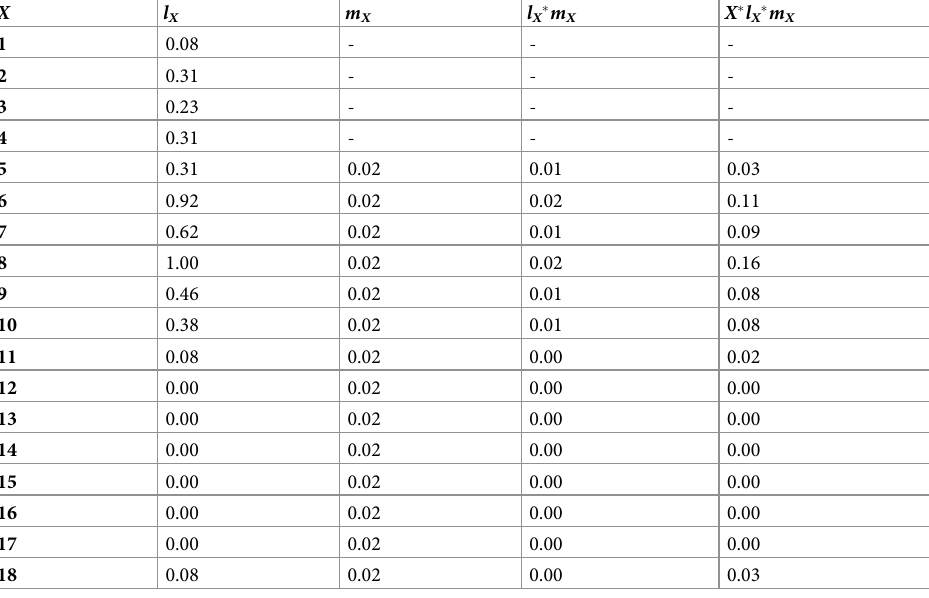
fertility), and the population density was then simulated separately with a matrix model that combined the time-specific life table and fertility table. Overall, the three populations in this study are declining populations. Population numbers of the WM and LM populations will sharply decrease according to Tables 9 and 11. The con- tinuous reduction of seedling stage plants and, at the same time, the loss of adults aggravates this situation by reducing seed sources and causing a vicious circle until the populations finally vanish. The BM population is different from the two populations mentioned above; its num- bers will increase in the mid-early term and decrease later, as shown in Table 13. Before N high survival rates of mid-aged individuals become the cornerstone of population numbers; Table 5. Fertility table of P . flavus WM